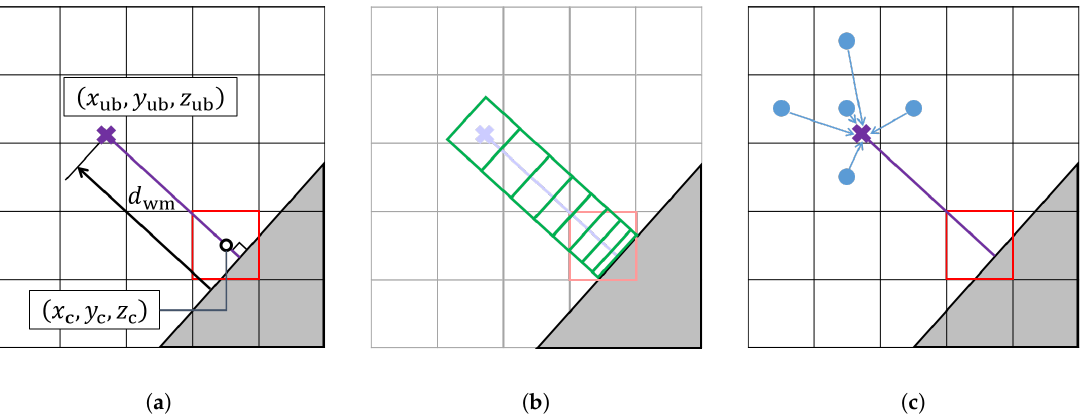
Figure 1. Overview of the application of the wall-stress model to the Cartesian cut-cell method. ( a ) Define the upper bound of the wall-stress model mesh using the wall distance d wm ; ( b ) Generate the one-dimensional mesh for the wall-stress model that is independent of the Cartesian cut-cell mesh; ( c ) Interpolate U (cid:107) and T to the upper boundary value of the wall-stress model using inverse distance